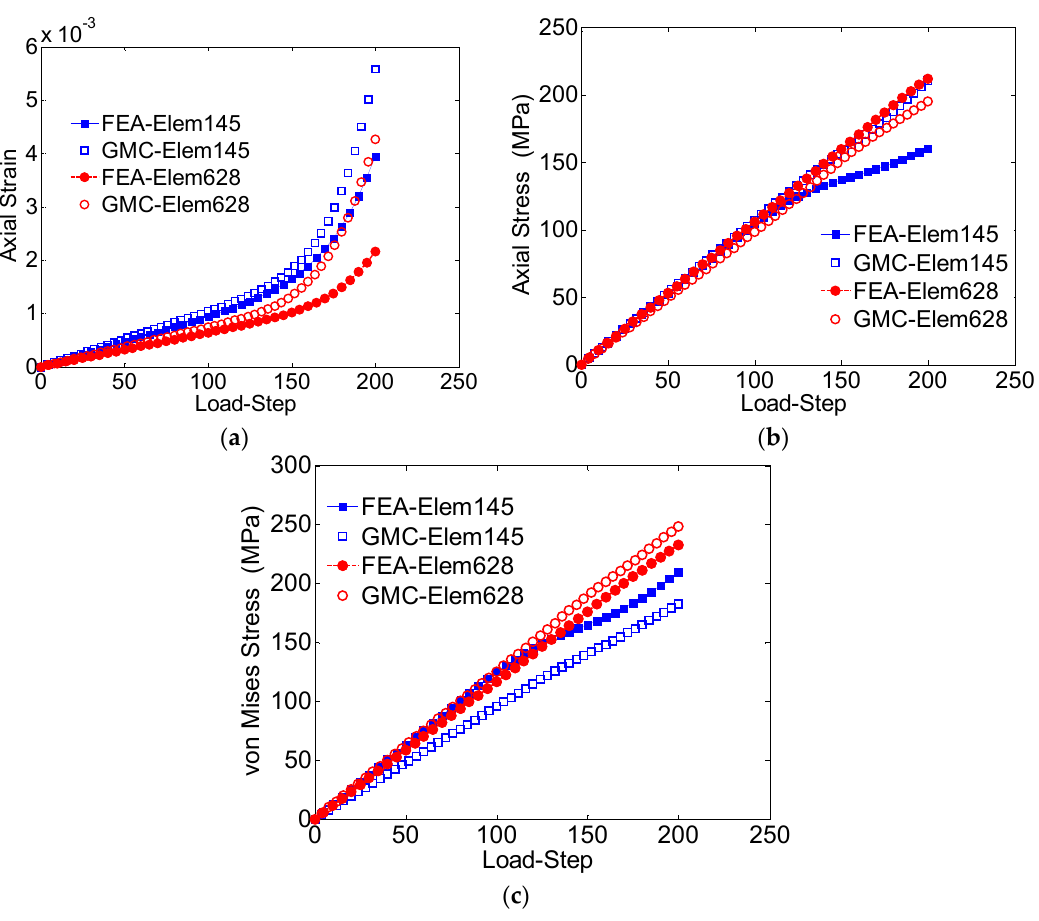
Figure 10. ( a ) Axial strain ( ε zz ) vs . load-step; ( b ) average axial stress ( σ zz ) vs . load-step; ( c ) von Mises stress vs . load-step, for two randomly selected elements/subcells.